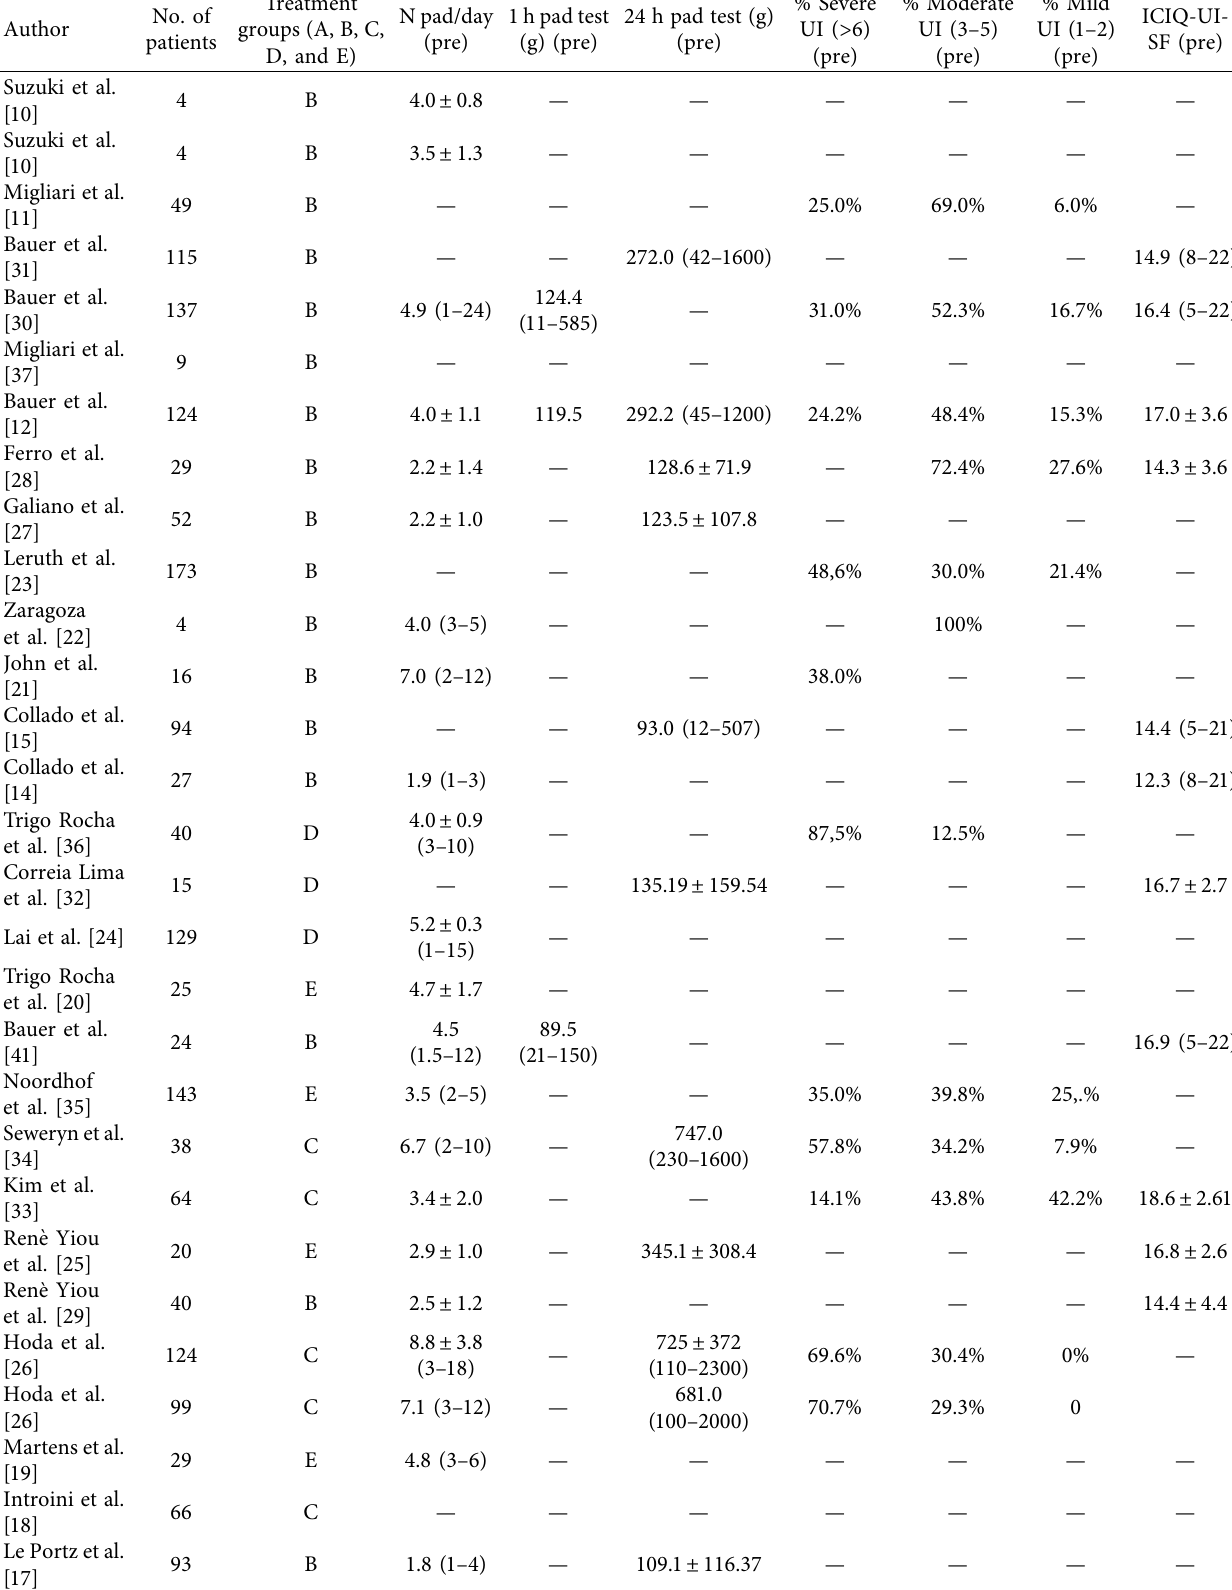
Table 3: 36 prospective clinical trials included in the analysis: baseline values. Number of cases; mean ± SD or median and (range).